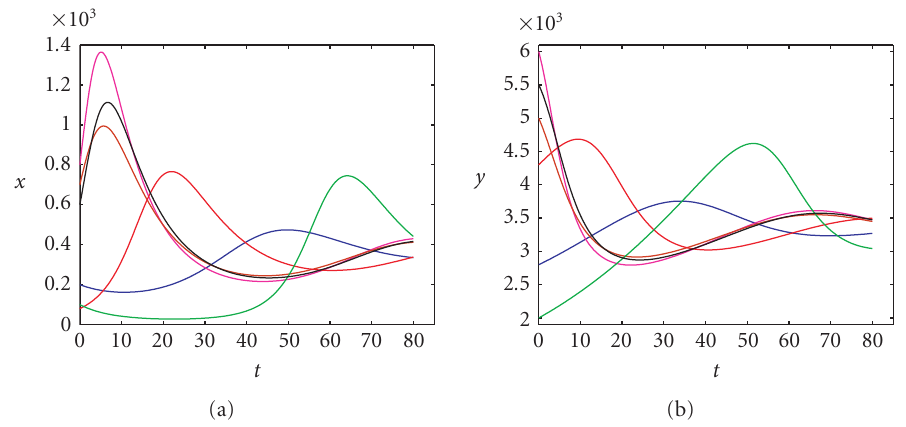
Figure 3.14. Time histories of response of the dynamical system with c = 0 . 7, and the parameters shown in Figure 3.13(a). (a) Terrorist population versus time. (b) Susceptible populations versus time.